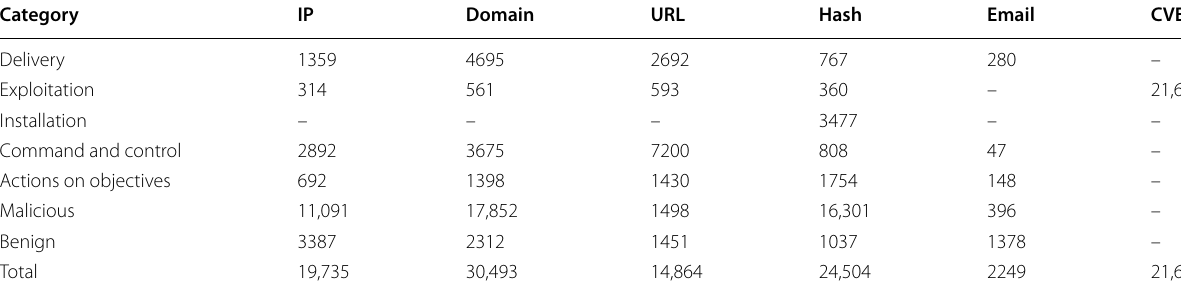
Table 5 TriCTI classification results statistics